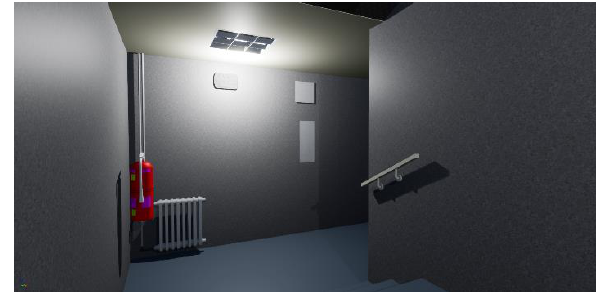
Figure 13. – Main entry to office